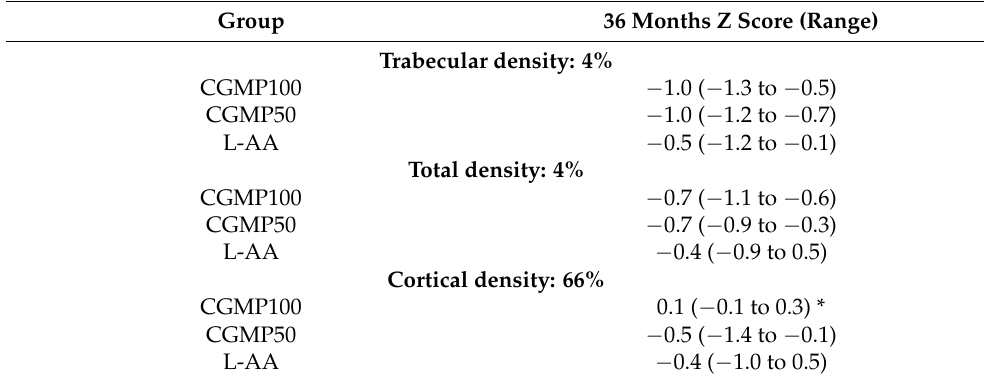
Table 3. Results from the pQCT scan measuring median z scores (range) for trabecular, cortical, and total densities at the 4% site; bone, muscle, and fat areas; strength strain index; and bone area/muscle area at 36 months in the CGMP100, CGMP50, and L-AA